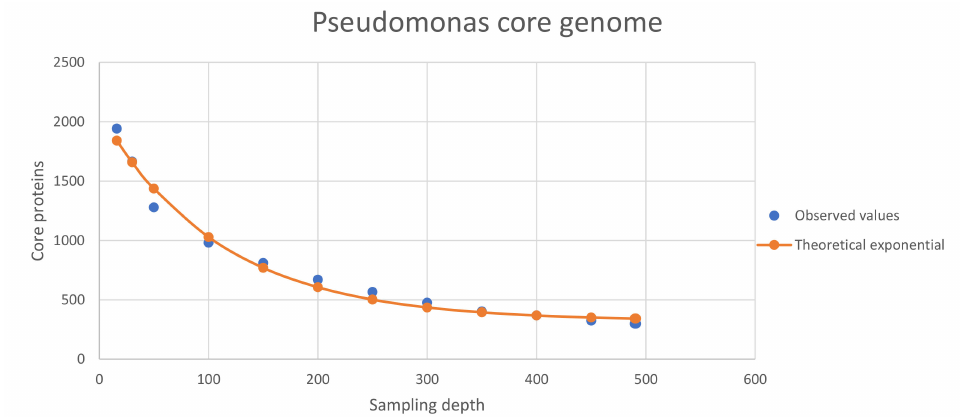
Figure 3. The Pseudomonas genus core proteome, depending on the sampling depth (i.e., number of proteomes